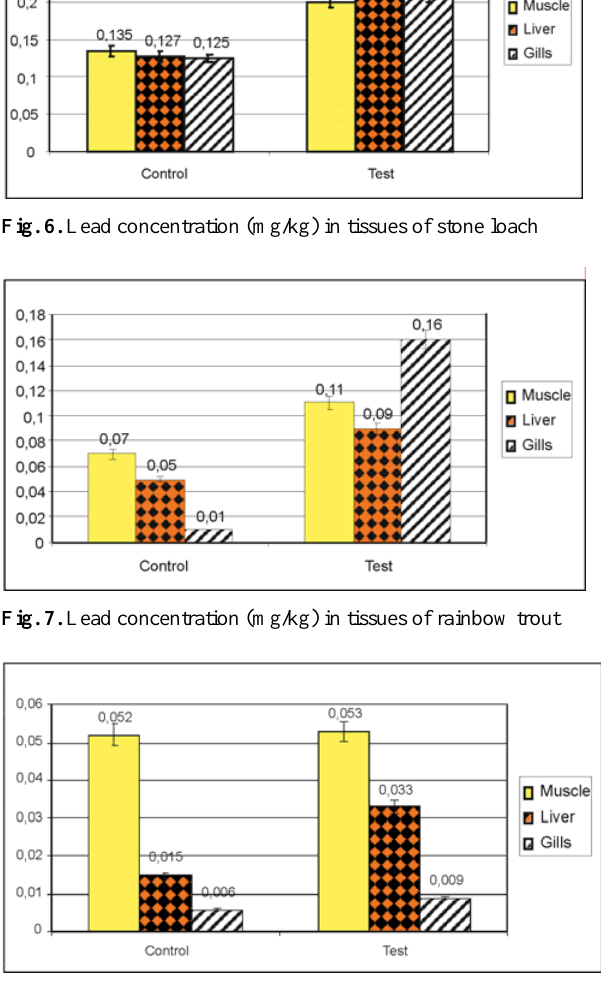
Fig. 8. Cadmium concentration (mg/kg) in tissues of stone